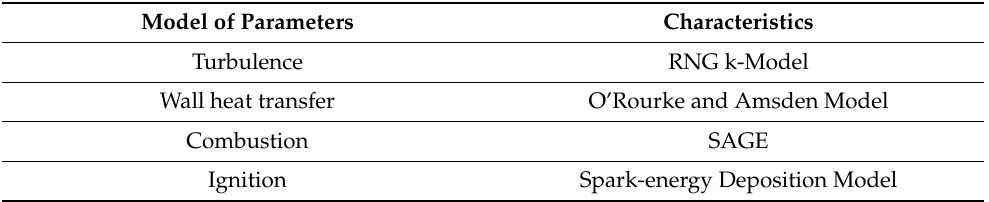
Table 3. Sub-model group used in CFD simulation. Reproduced with permission from Li, G., etc., Int. J. Hydrog. Energy; published by Elsevier, 2019 [28,30].